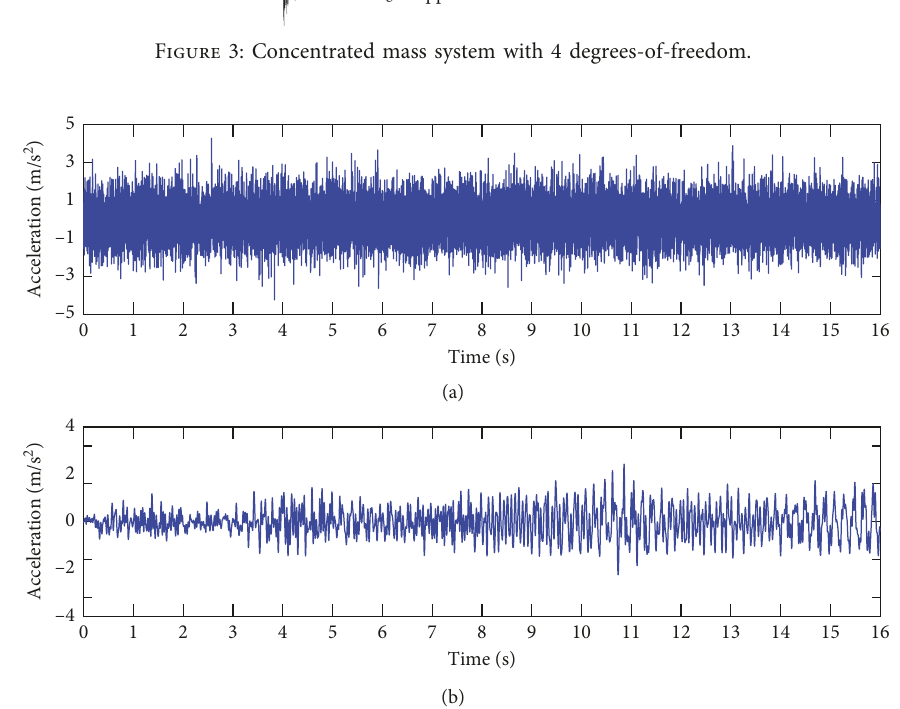
Figure 4: Support excitation and vibration response of m response of m 1.